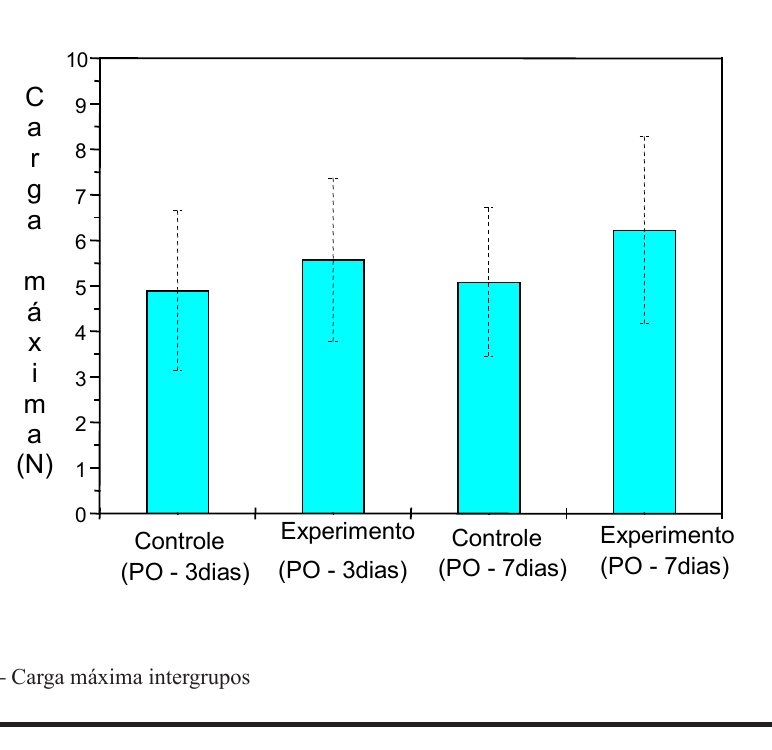
FIGURA 17 – Carga máxima intergrupos